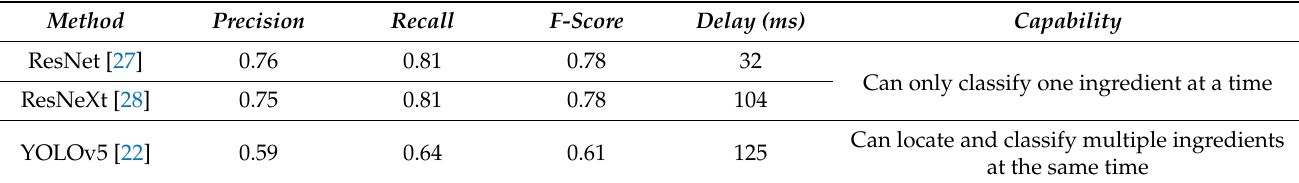
Figure 10. Recognition accuracy and confusion matrix of 11 food ingredients. Table 3. Performance, speed, and capability of three deep learning